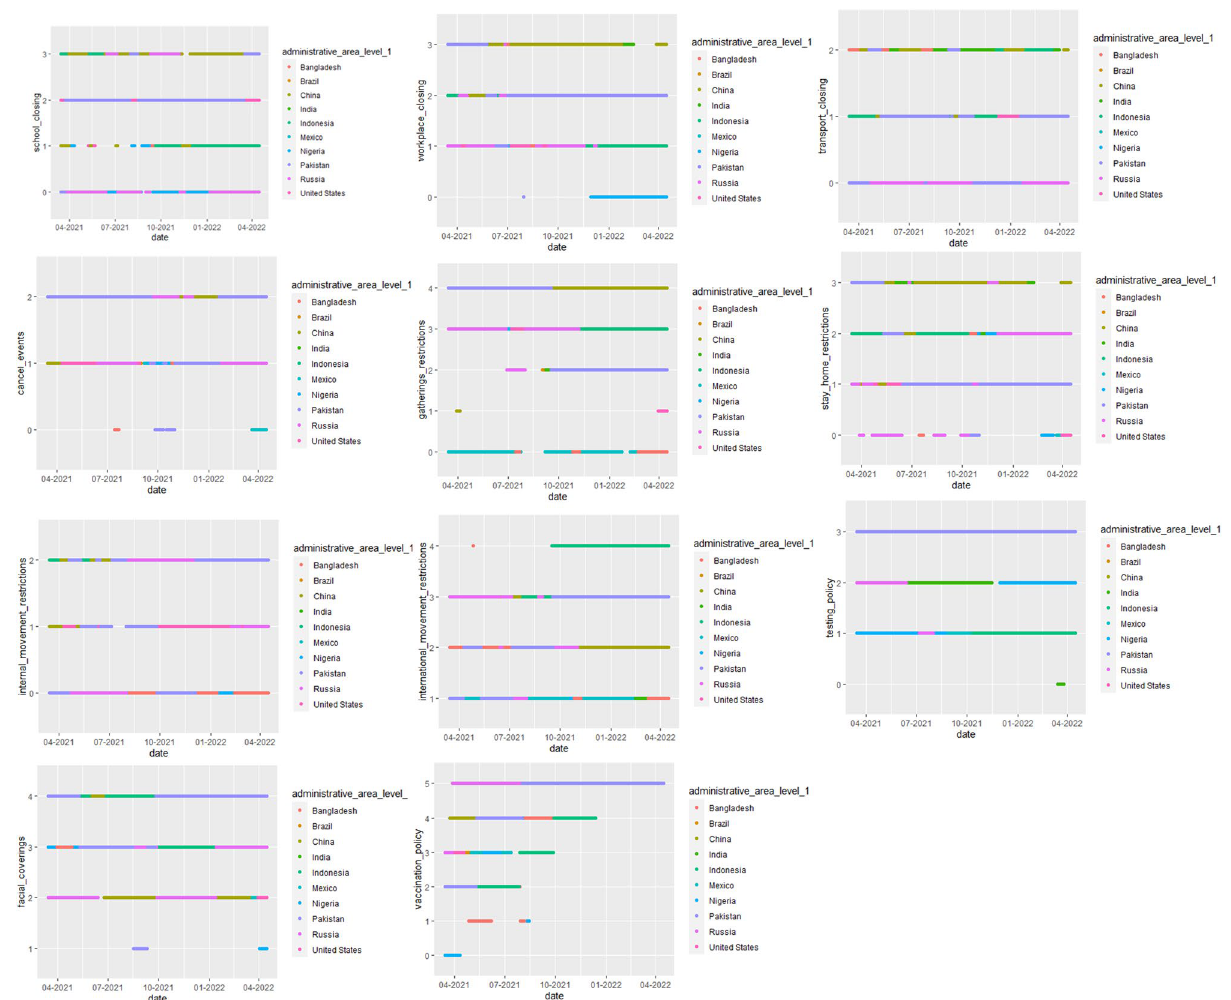
Figure 1. Policies of Countries during